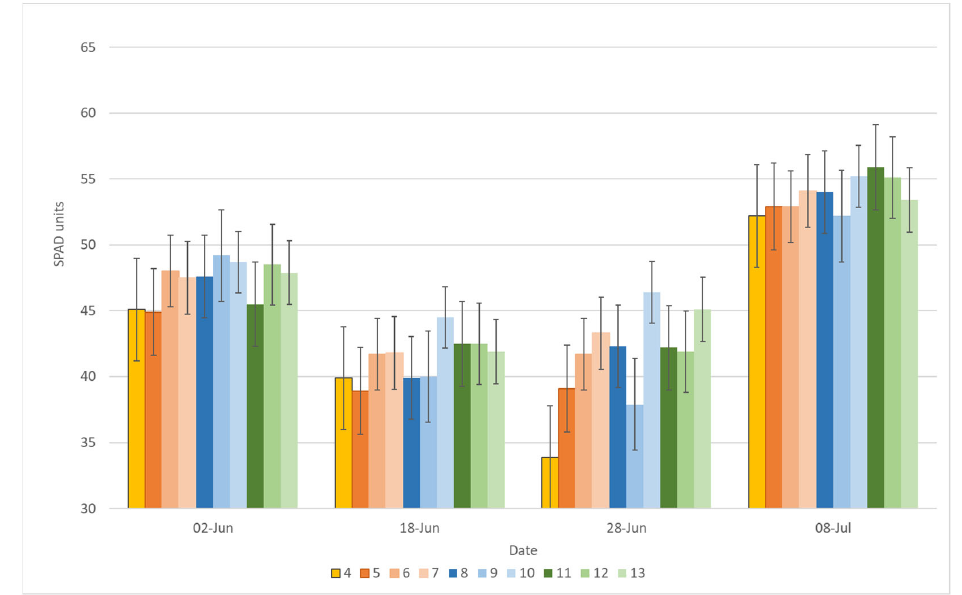
Figure 3. SPAD value of oat in different mixed cropping treatments, averaged over the three years, depending on the vegetation date. Note: 1, Pea J ū ra DS; 2, Pea Egle DS; 3, Pea Lina DS; 4, Oat Viva DS; 5, Pea J ū ra DS 50% + 50% oat; 6, Pea J ū ra DS 60% pea + 40% oat; 7, Pea J ū ra DS 70% + 30% oat; 8, Pea Egle DS 50% + 50% oat; 9, Pea Egle DS 60% pea + 40% oat; 10, Pea Egle DS 70% + 30% oat; 11, Pea Lina DS 50% + 50% oat; 12, Pea Lina DS 60% pea + 40% oat; 13, Pea Lina DS 70% + 30% oat.